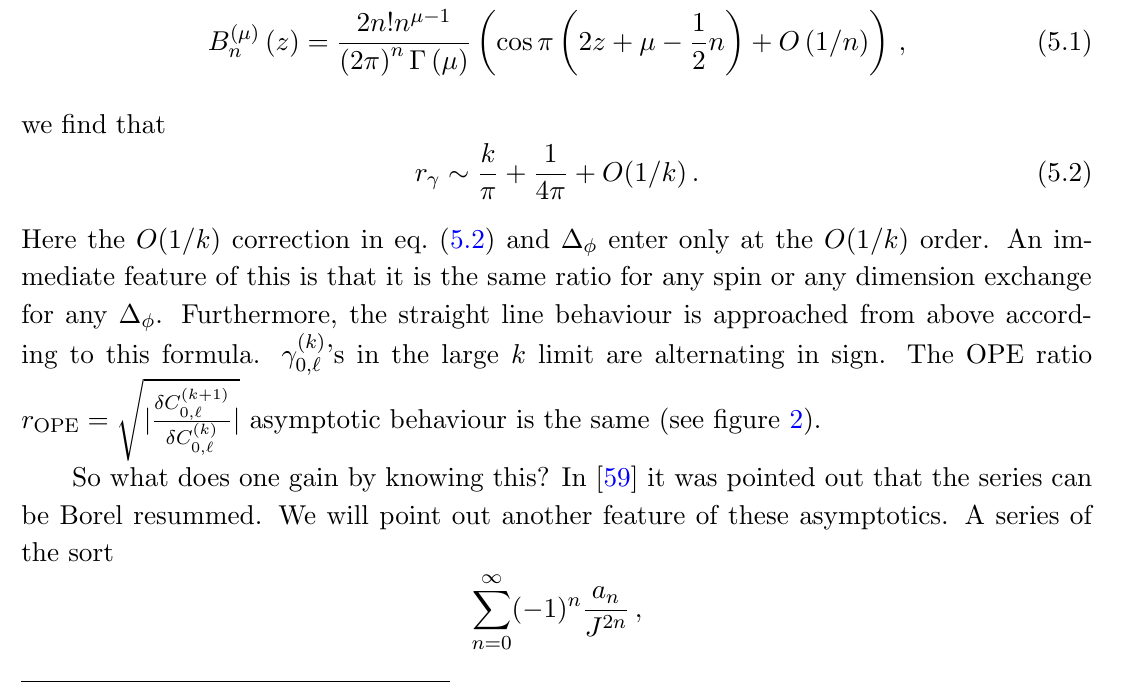
log-log plot below, for large k , r